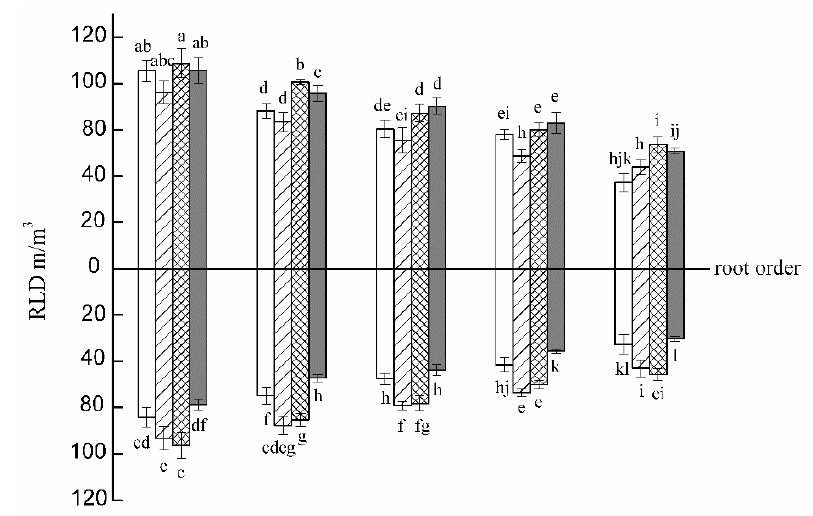
massoniana . The X axis is the first to the fifth root order. The bars above the X axis represent the crop trees, and the bars below the X axis represent the noncrop trees. I, II, III, and IV represent the distance of fine roots to the target tree at 0–0.5, 0.5–1, 1–1.5, and 1.5–2 m. Each bar represents the mean ± SD with three replicates. Different letters above or below each bar indicate significant differences among groups compared by Fisher’s LSD test at p < 0.05.